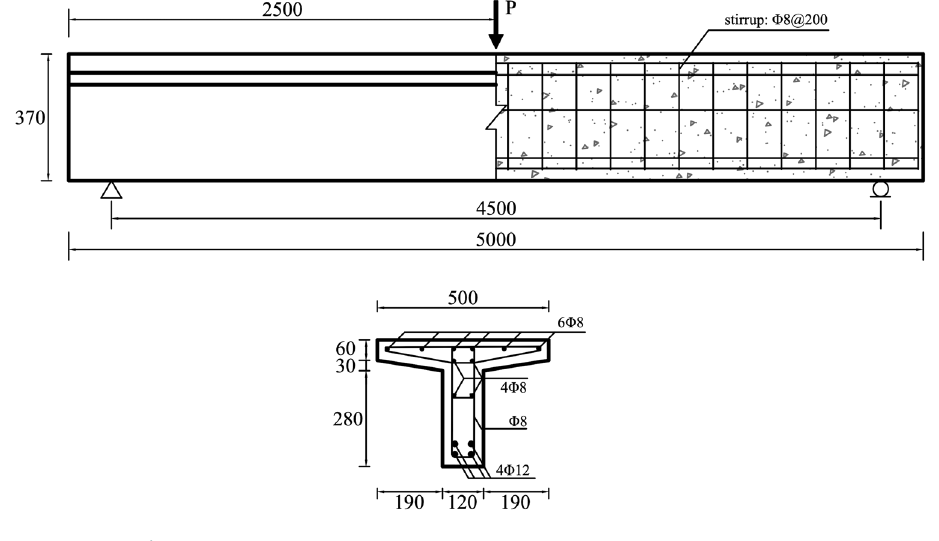
Figure 1. Details of the RC beams (unit: